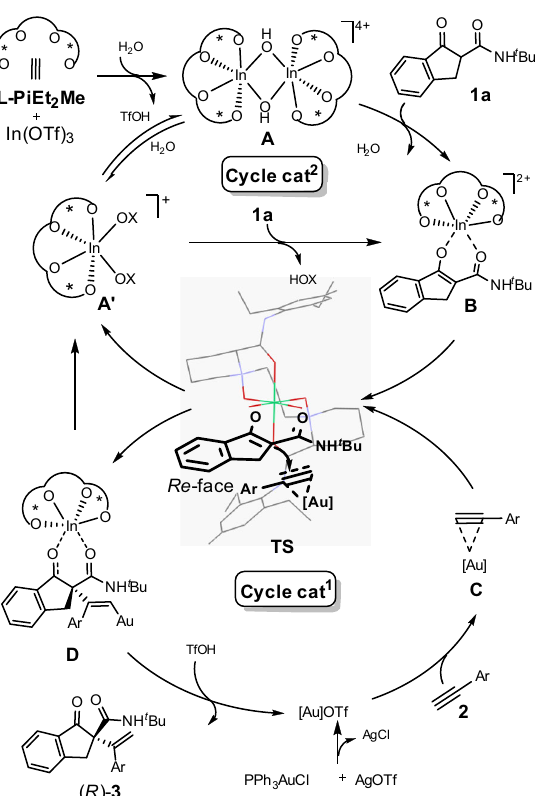
Fig. 7 Proposed catalytic cycle and transition-state model. The in situ formed chiral N , N ′ -dioxide-indium(III) Lewis acid actives the 1,3-dicarbonyl compounds (intermediate B ) and achiral gold(I) π -acid actives the alkyne (intermediate C ) synergistically; the two intermediates reacts following subsequent protonation, giving the desired product 3 and releases the two